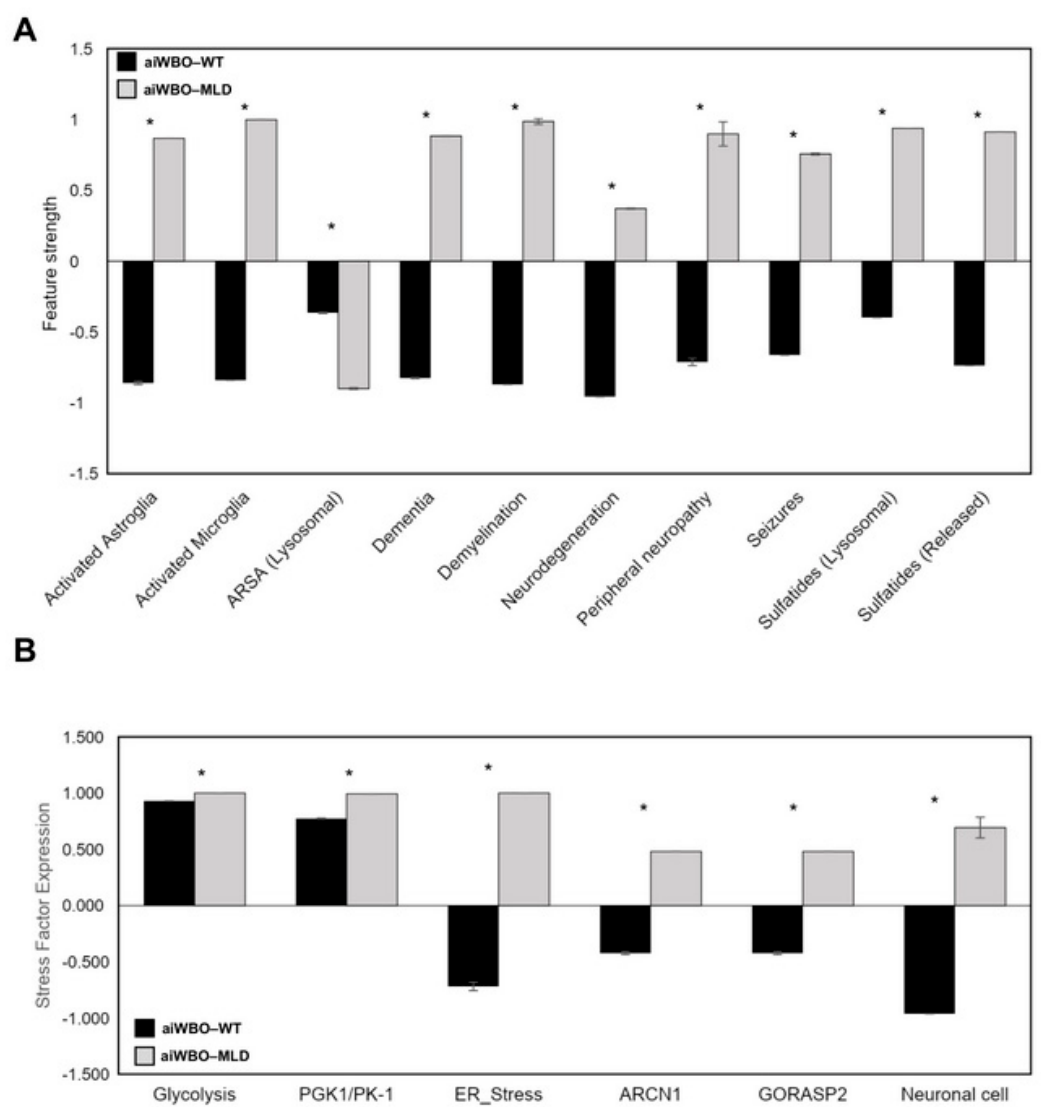
Figure 3. Simulation results of aiWBO–MLD disease profile, cellular stress and neuronal cell death. ( A ), Simulation of MLD features in reference to WT. ( B ), comparative simulation predictions of cellular stress and neuronal cell death in aiWBO–WT vs aiWBO–MLD. The vertical y-axes represent the semiquantitative levels of concepts that are estimated by DeepNEU relative to an arbitrary base line where 0 = base line, 1 = maximum expression or presence and − 1 = minimal expression level or presence. The horizontal x-axes represent the individual aiWBO concepts being simulated. Data represent means of three experiments ± 95% confidence interval. All p values from Mann-Whitney U test. * p < 0.01.